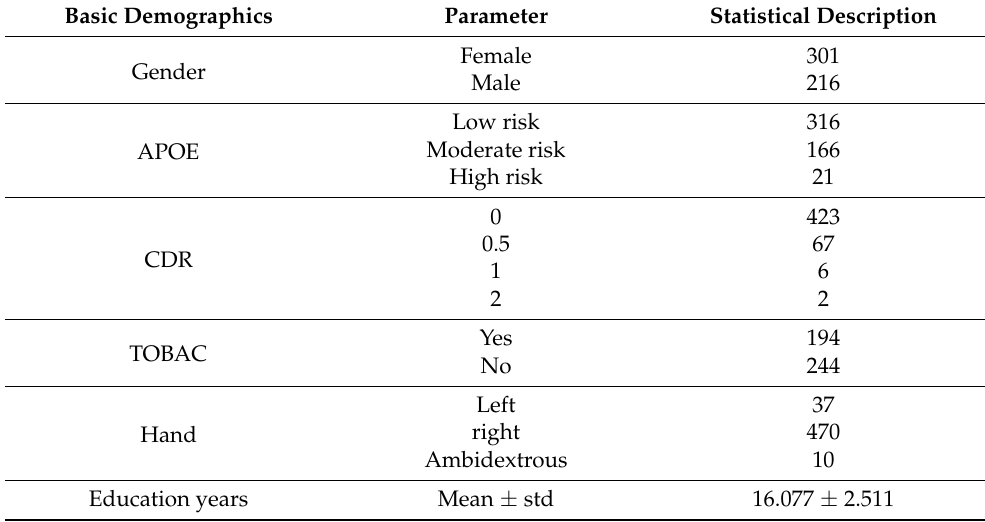
Table 1. Description of the OASIS-3 cohort of 532 sub-datasets included in this work. Basic Demographics Parameter Statistical Description